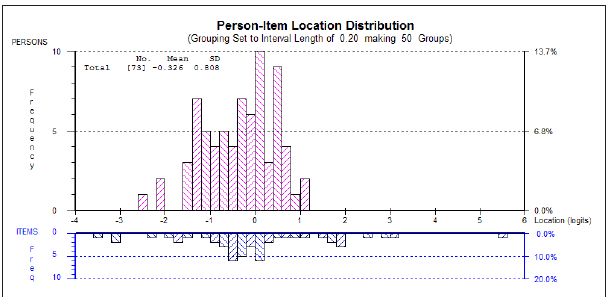
FIGURE 15: Person-item location distribution after refinement to